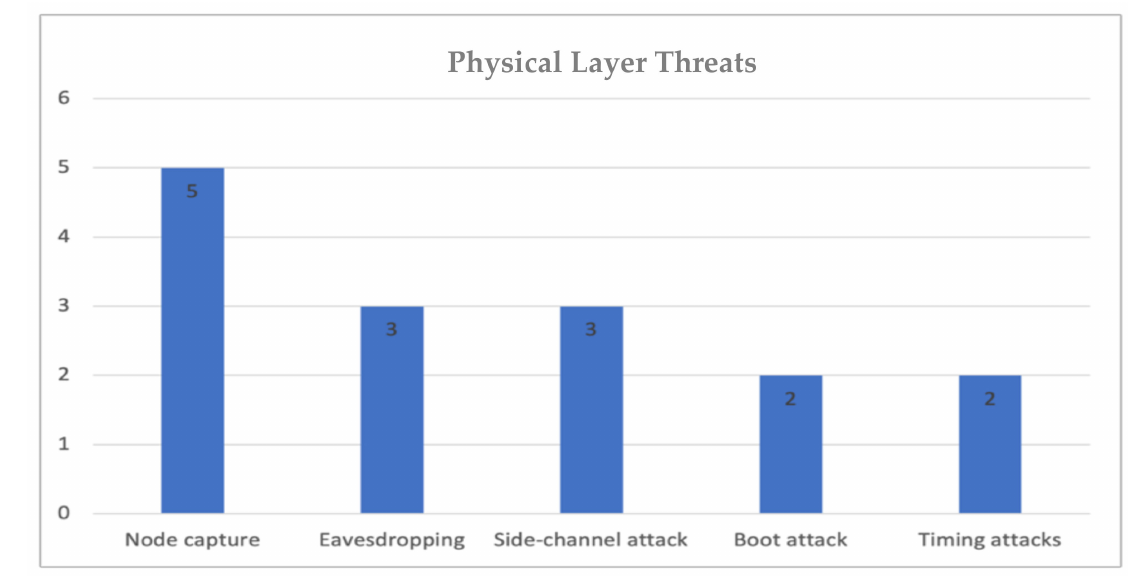
Figure 6. Common threats in the IoT physical layer.